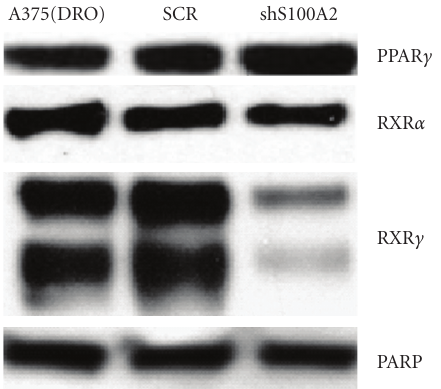
Figure 6: Western blot of rexinoid receptors in A375(DRO) cells after knock down of S100A2. 60 μ g of nuclear protein extract from A375(DRO), the SCR shRNA-infected control cell, and a clone of shS100A2 infected cells were size-separated on a 10% SDS-PAGE gel and transferred to nitrocellulose. The blot was blocked with 10% nonfat milk and incubated with PPAR γ , RXR γ , and RXR α primary antibodies and then secondary antibody with antirabbit IgG conjugated to horse-radish peroxidase as previously described. PARP was measured as a loading